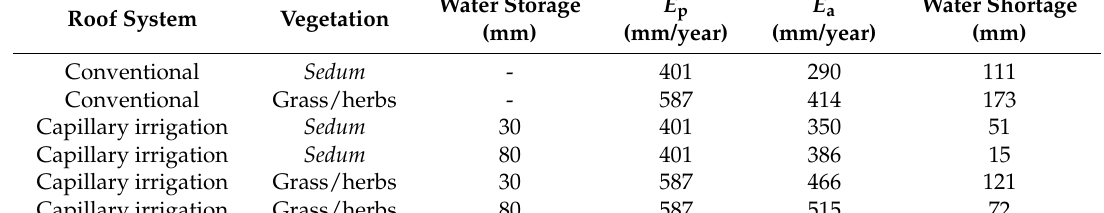
Table 1. Long-term annual mean cumulative evaporation.